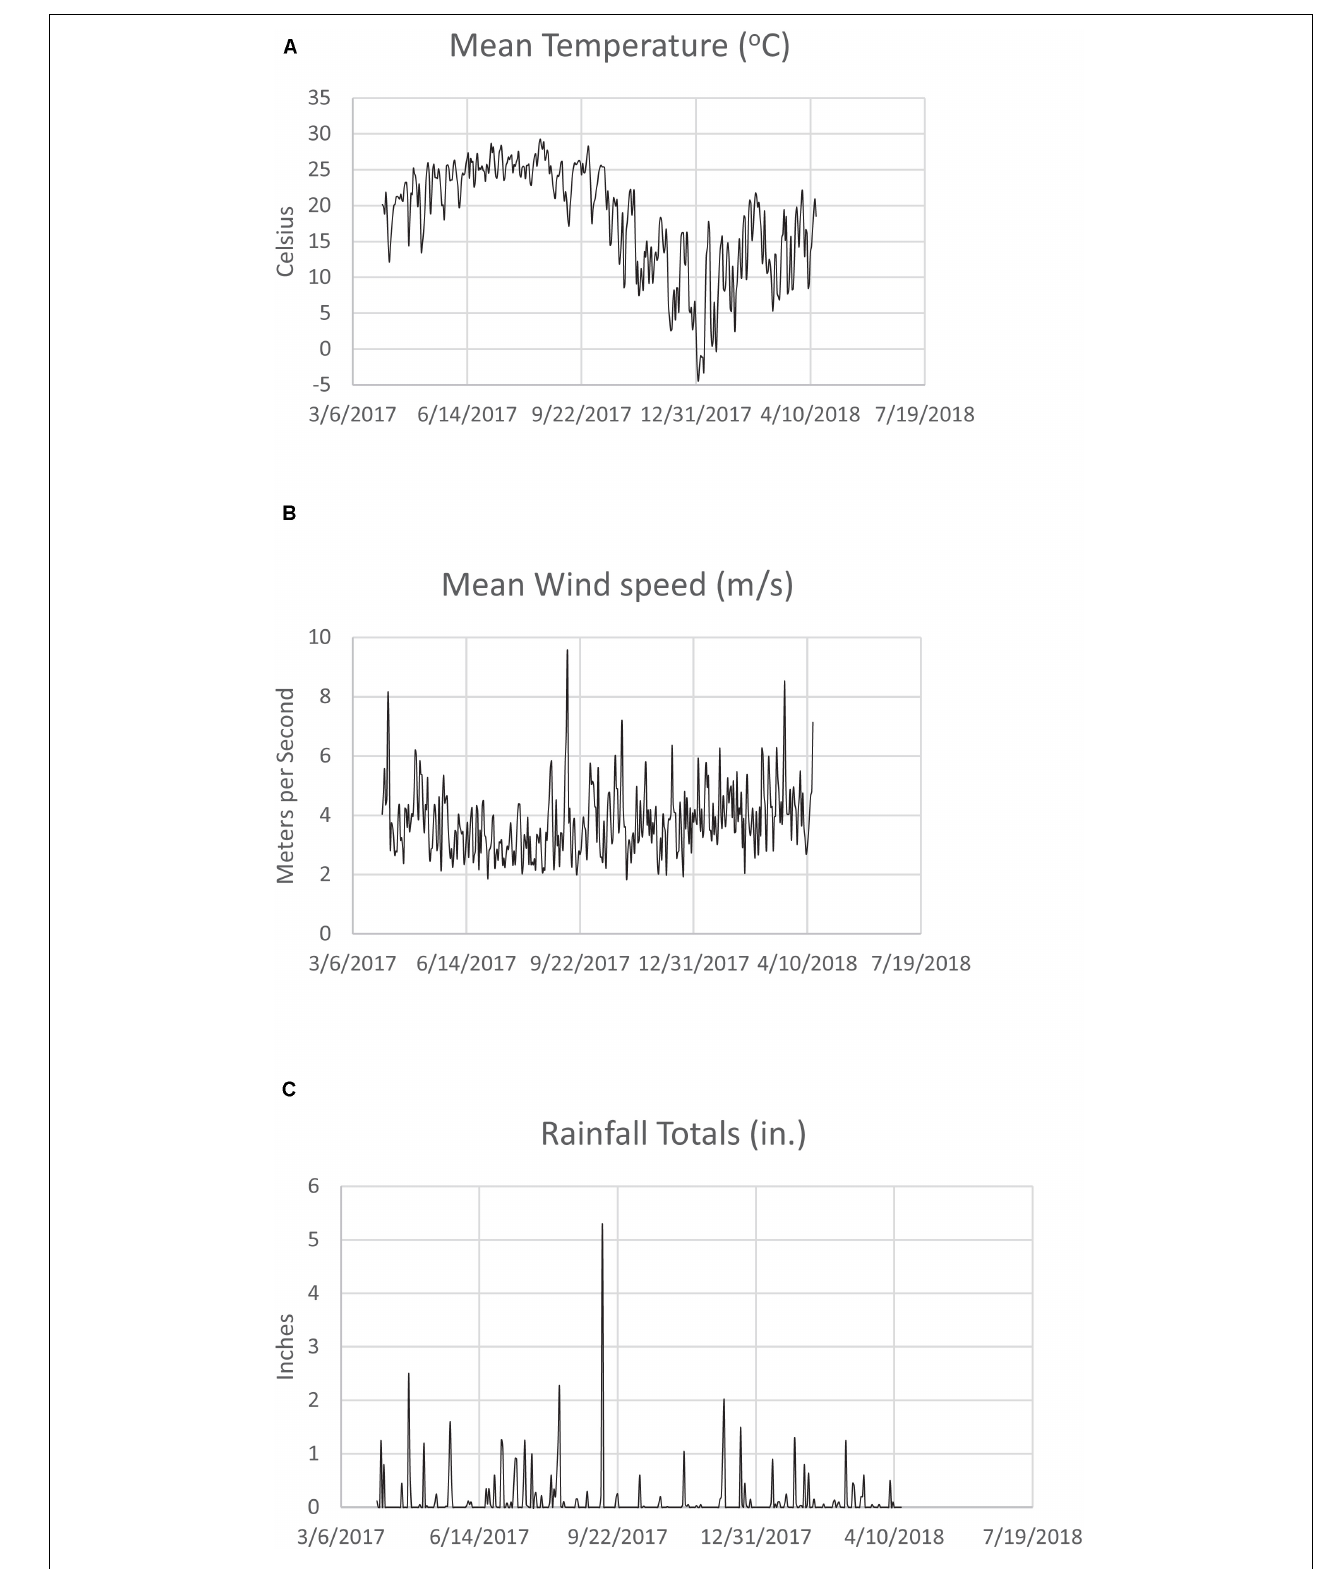
FIGURE 2 | (A) Mean monthly Savannah River Site temperature ( ◦ C) for 3/6/2017–7/19/2018. (B) Mean monthly Savannah River Site wind speed (m/s) for 3/6/2017–7/19/2018. (C) Mean monthly Savannah River Site rainfall (in.) for 3/6/2017–7/19/2018.